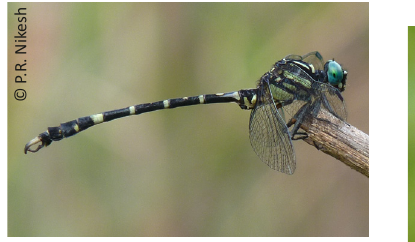
Image 8. Onychogomphus striatus